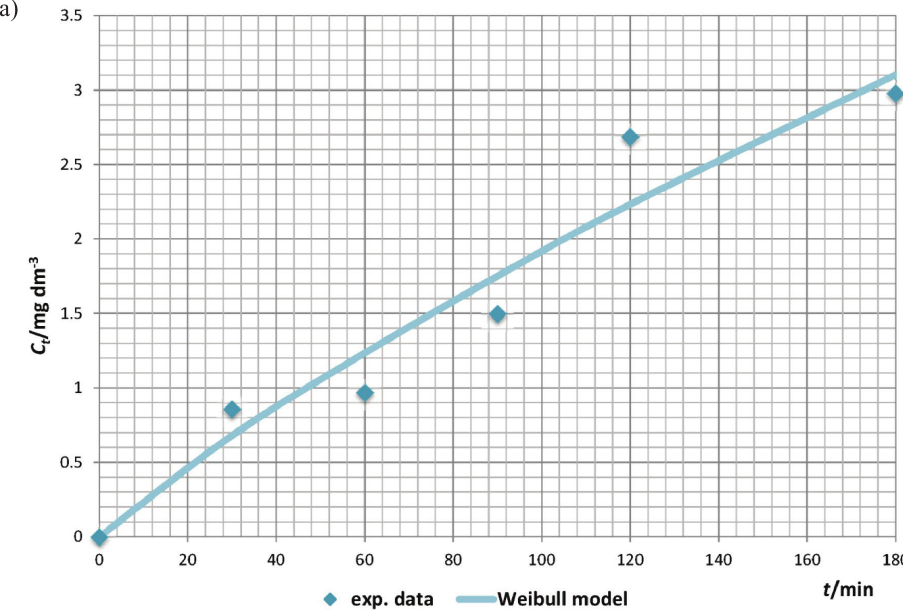
Fig. 10 – Applicability of Weibull model to the experimental data for vitamin E release from zeolite